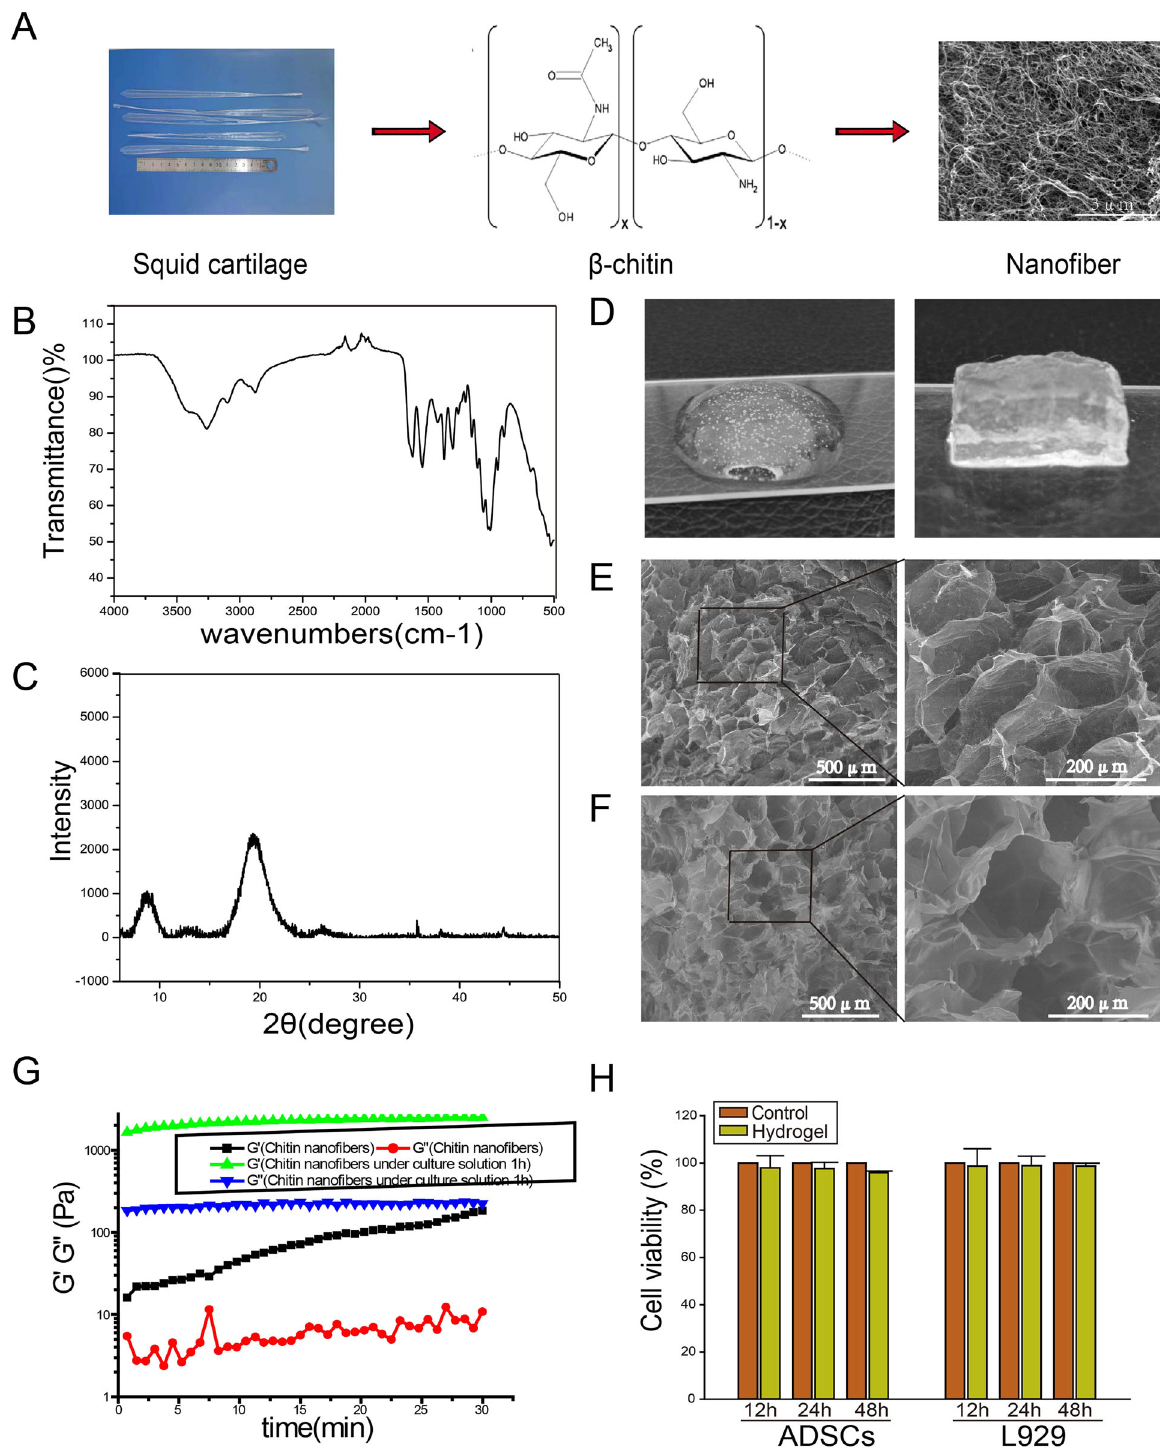
Fig. 1 The characterization of β -chitin nano fi bers hydrogel. A The sketch map of β -chitin nano fi bers preparated from squid cartilage. B FTIR spectra and ( C ) XRD pro fi le suggested a β -chitin structure. D Representative digital photographs of the β -chitin nano fi bers hydrogel before and after the reaction with cell culture medium. E SEM image